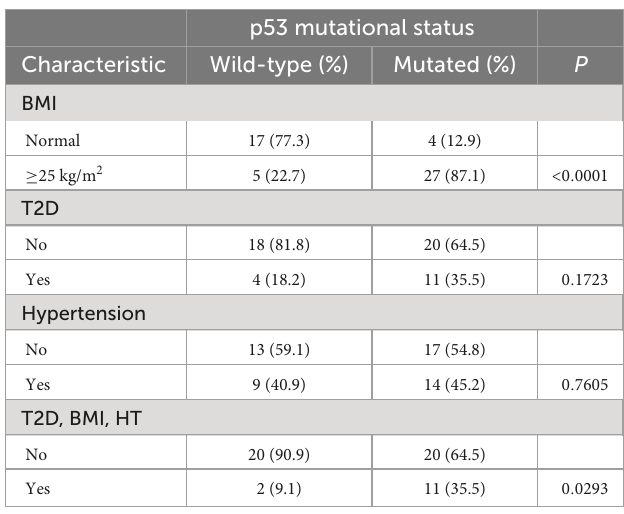
TABLE 7 Associations between BMI, T2D, hypertension, and p53 mutational